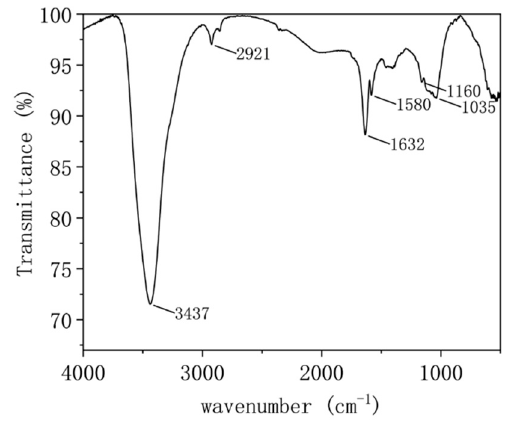
Figure 6. Infrared spectrogram of MEG.